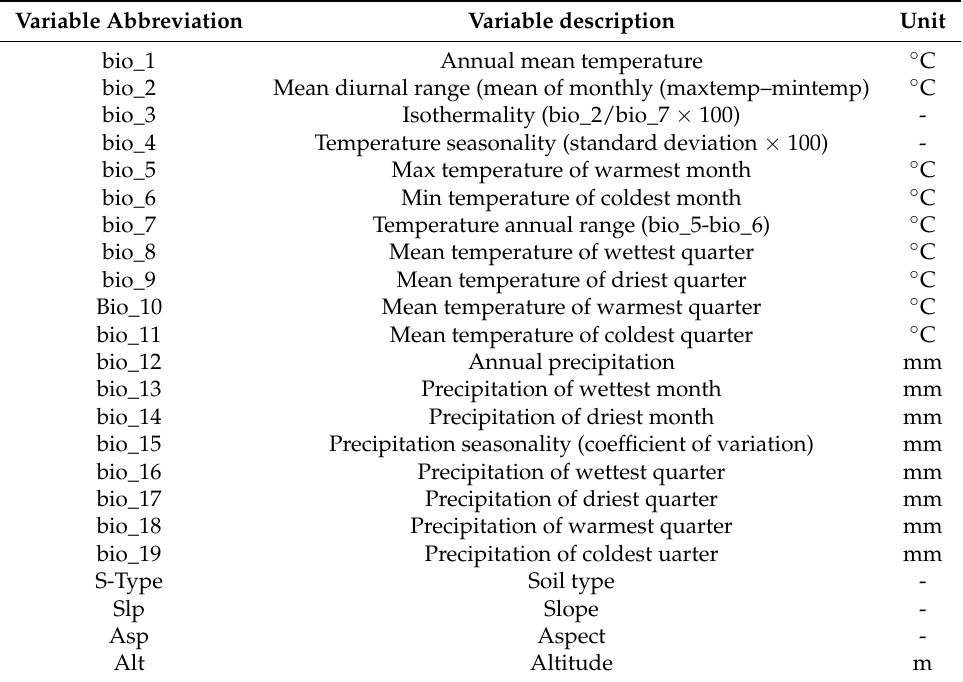
Table 2. Description of environmental variables.